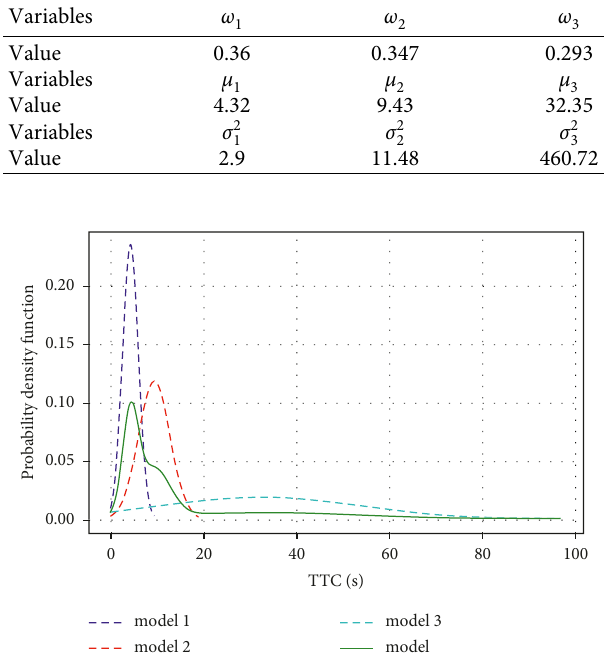
Figure 4: The three Gaussian model distributions.